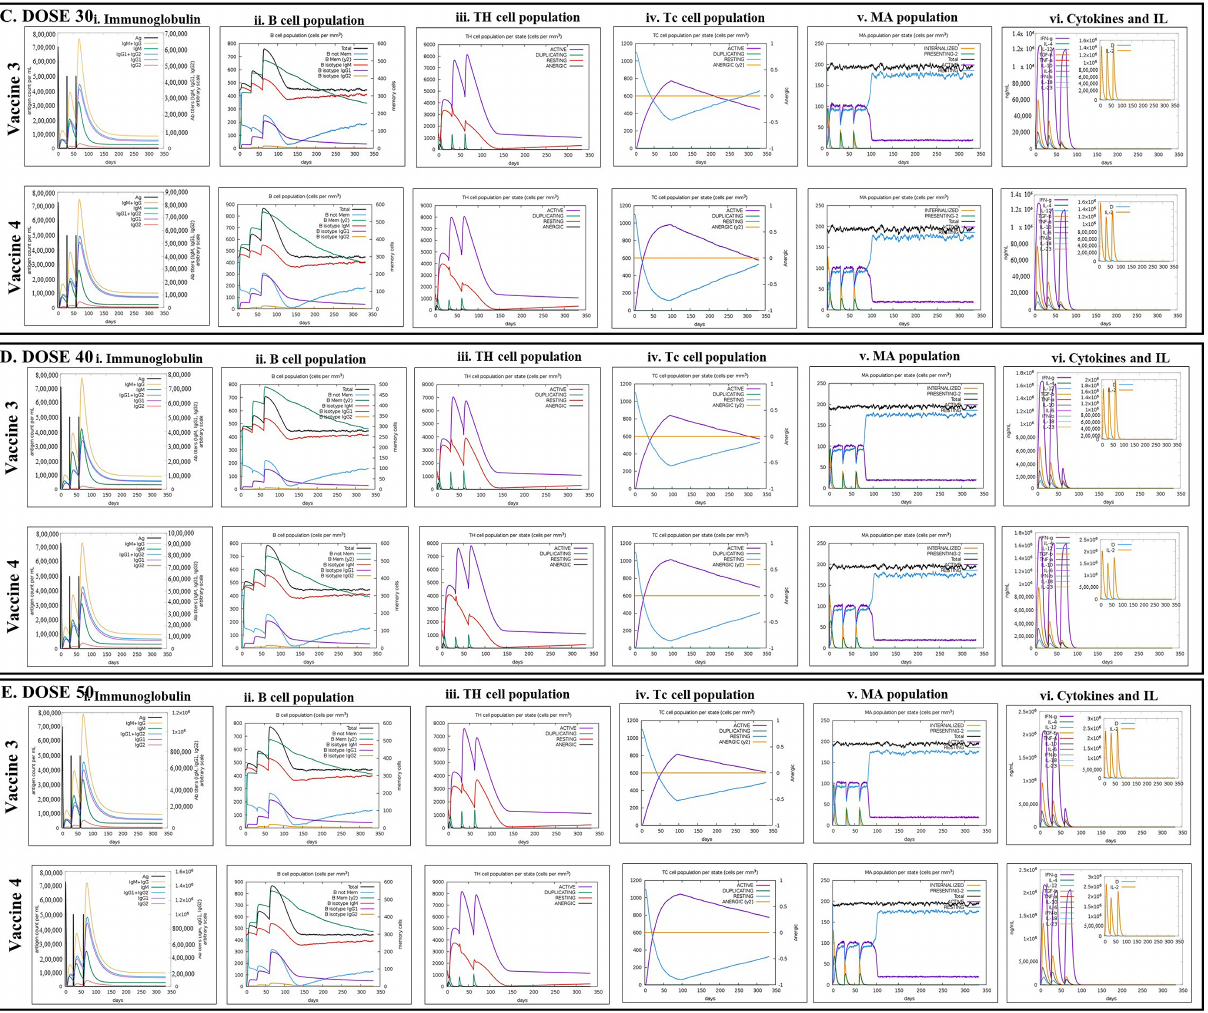
Figure 7. In silico immune simulation showing the comparative efficacy of the designed vaccines in inducing immune responses. Immune response for the simulation Volumes of ( A ) dose 10, ( B ), dose 20, ( C ), dose 30, ( D ), dose 40, and ( E ), dose 5 showing the ( i ). production of several subclasses of immunoglobulin (colored lines) in response to vaccine injection (black vertical lines), ( ii ). B-cell richness after three injections, ( iii ). Evolution of Th-cells after the injections, (iv). Evolution of Tc-cells after the injections. ( v ). Production of macrophage. ( vi ). Production of cytokine and interleukin